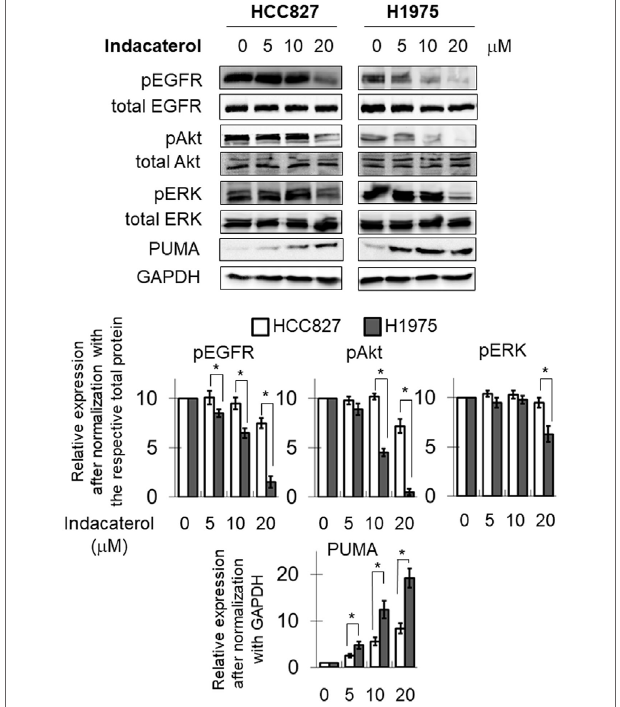
FigUre 2 | Western blot analysis showing the inhibition of the epidermal growth factor receptor (EGFR)–PI3K–Akt pathway by one of the three positive drug candidates (indacaterol) in both EGFR sensitizing mutation-bearing HCC827 cells and resistance-causing EGFR T790M mutation-bearing H1975 cells. The extent of inhibition of EGFR, Akt, and ERK phosphorylation is summarized after normalization with the respective total protein as bar graphs (lower panel). * p < 0.05, Student’s t -test, compared with the data in HCC827 cells. Cropped blots from different gels are grouped together for clear illustration. The full-length gels are shown in Figure S3 in Supplementary